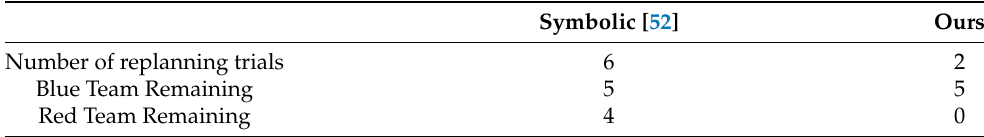
Figure 11. Experimental environment setting to verify the proposed framework: ( a ) executing WP surveillance tasks by operating the blue team and red team consisting of two groups each, ( b ) simula- tion environment size and LiDAR detection distance of each agent. Table 3. Results of our approach and comparison